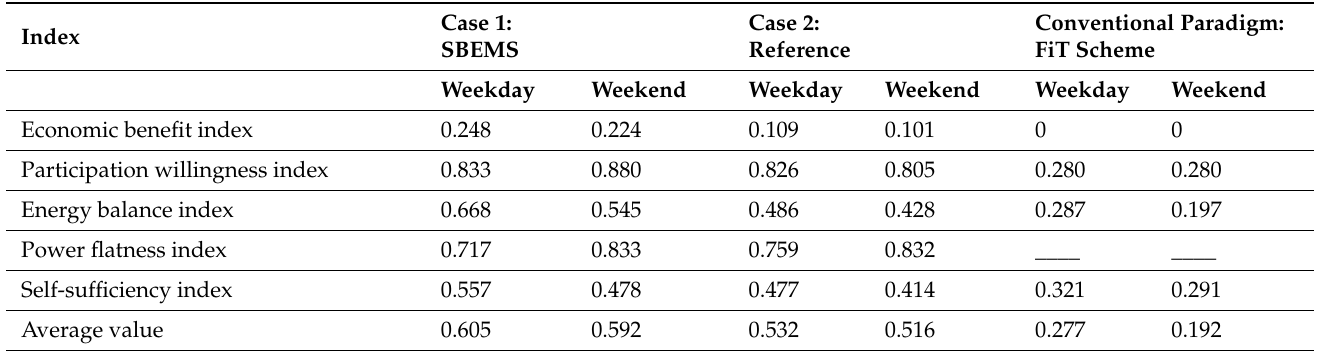
Table 2. Comparison of technical and economic